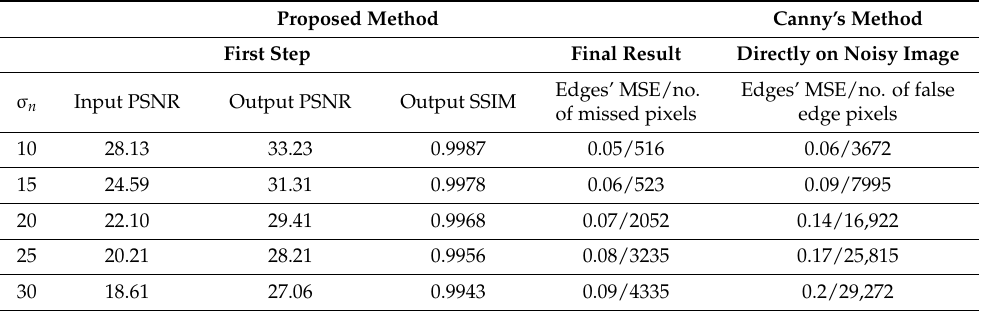
Table 3. Image Barbara. A comparison of the results obtained for the proposed method and for Canny’s edge detector directly applied to the noisy image, for different values of the noise standard